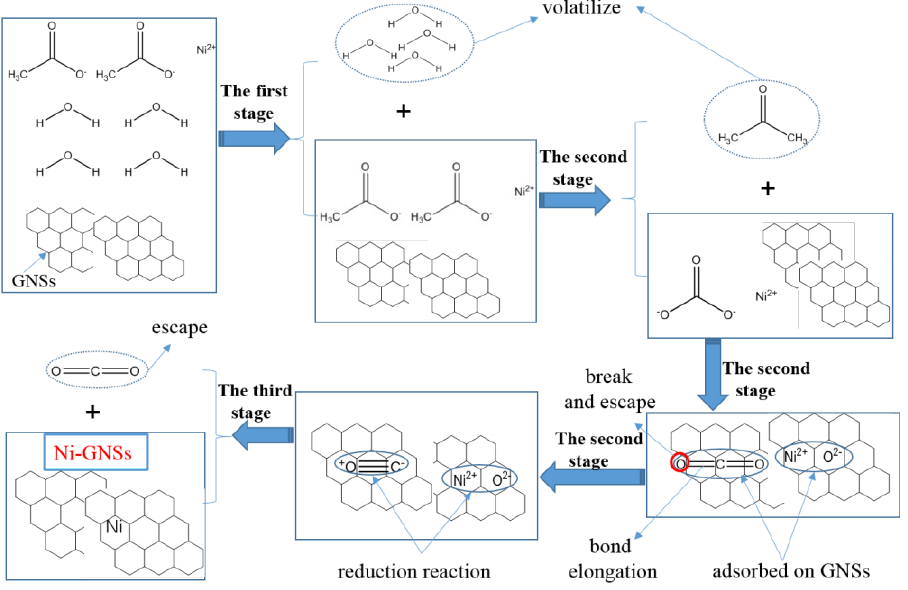
Figure 10. Schematic diagram for the formation mechanism of Ni-GNSs.